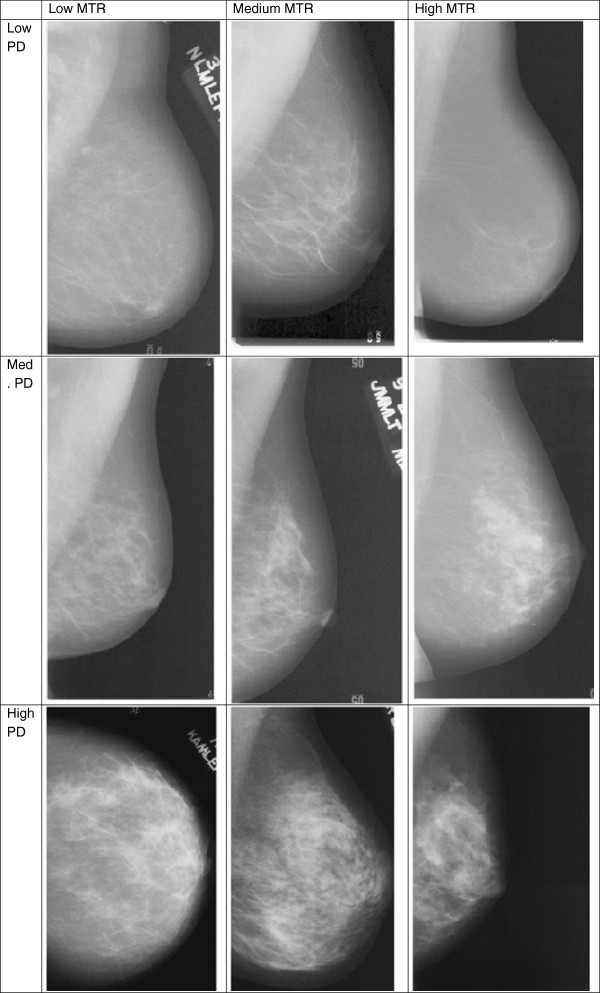
Mammograms representing each tertile of percent density and mammographic texture resemblance (MTR) scores in S2. High MTR images seem to have coarser, more large-scale texture.